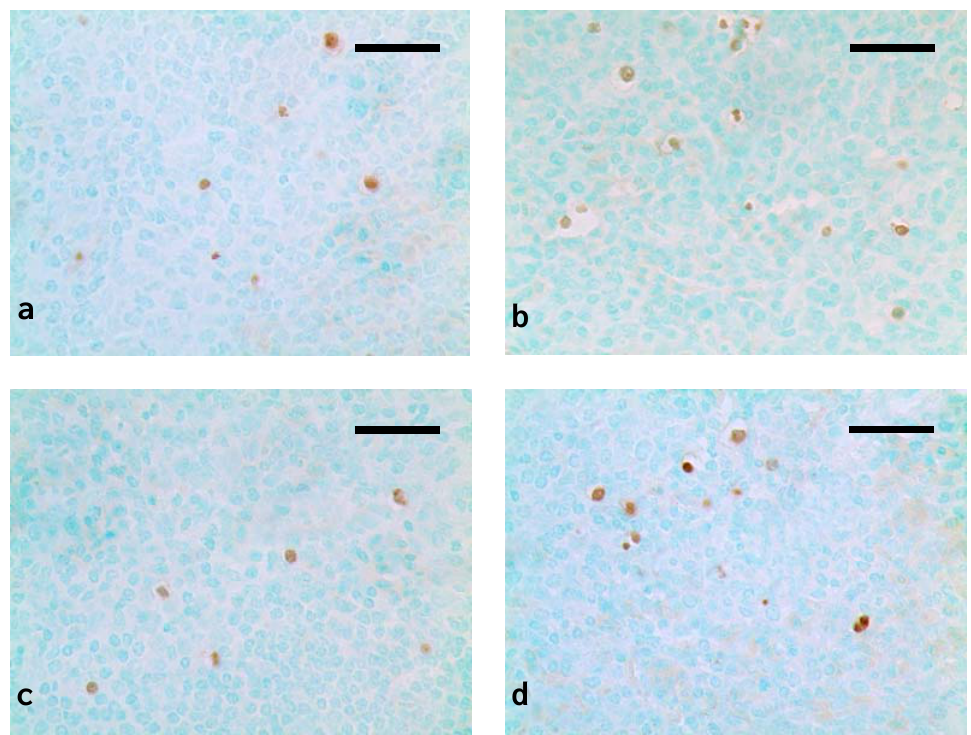
Figure 4. Histological images of TUNEL